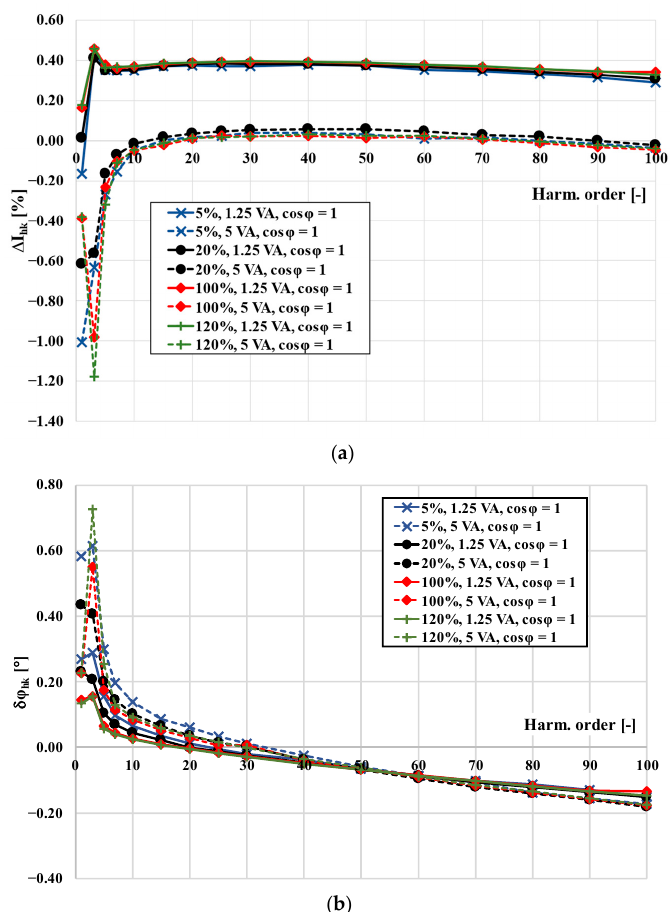
Figure 2. Influence of the secondary winding resistive load of a 300 A/5 A CT on its transformation accuracy: ( a ) current error; ( b ) phase displacement.